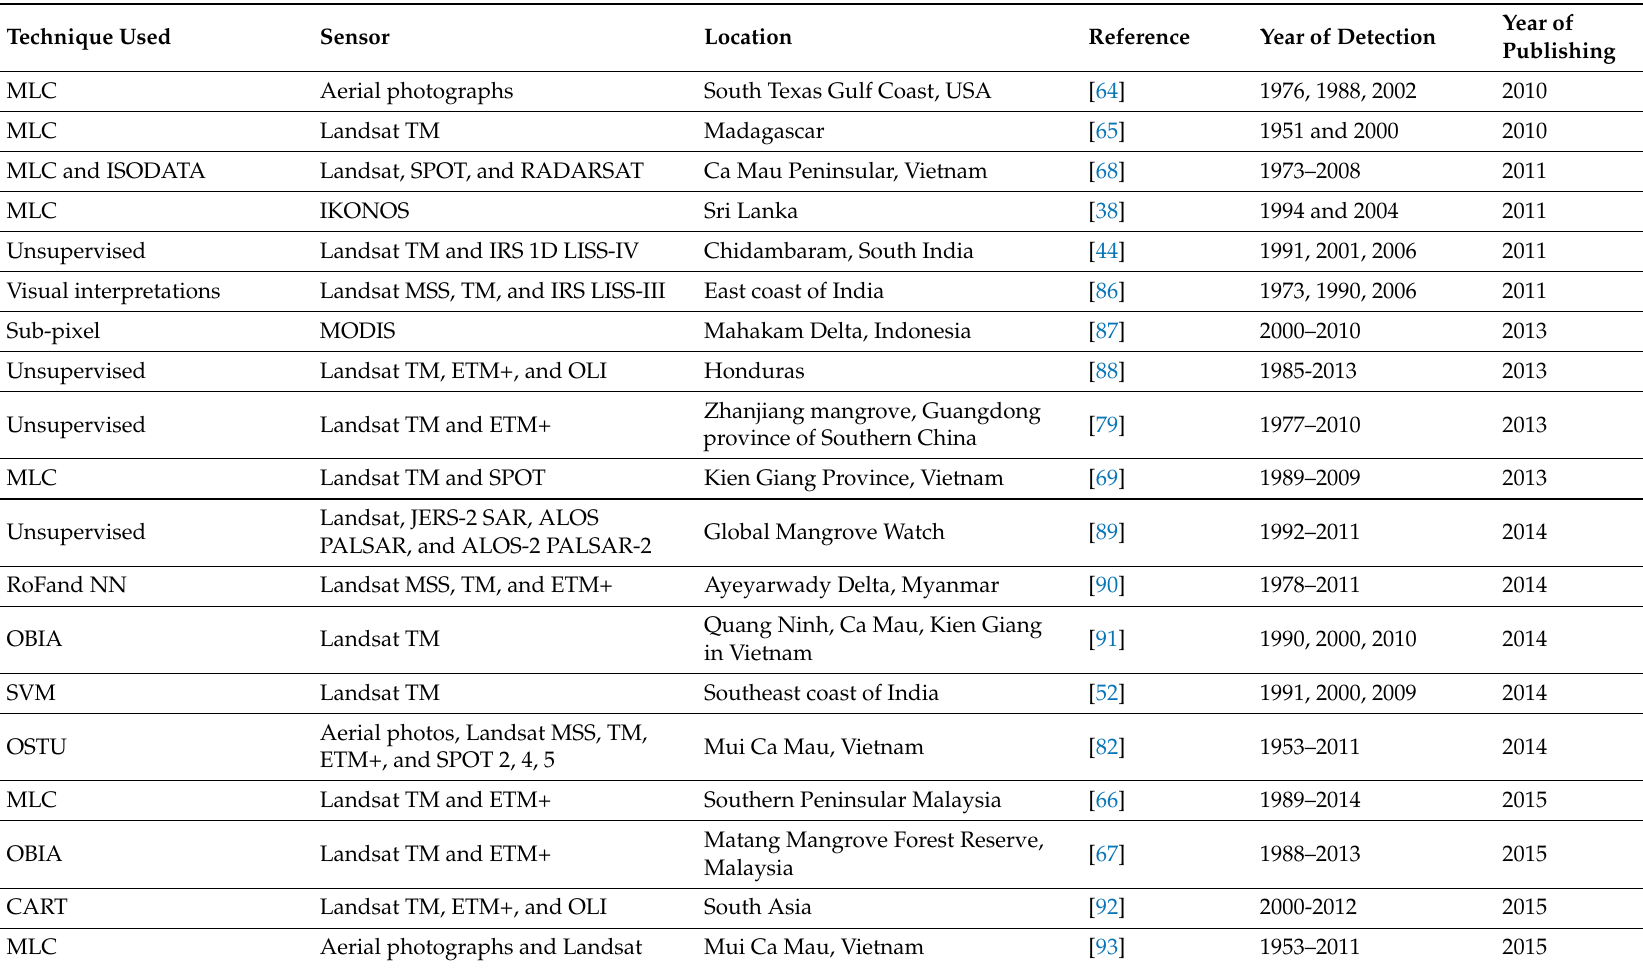
Table 3. Remote sensing techniques for monitoring mangroves using remotely-sensed data from 2010–2018. MLC, maximum livelihood classifier. Technique